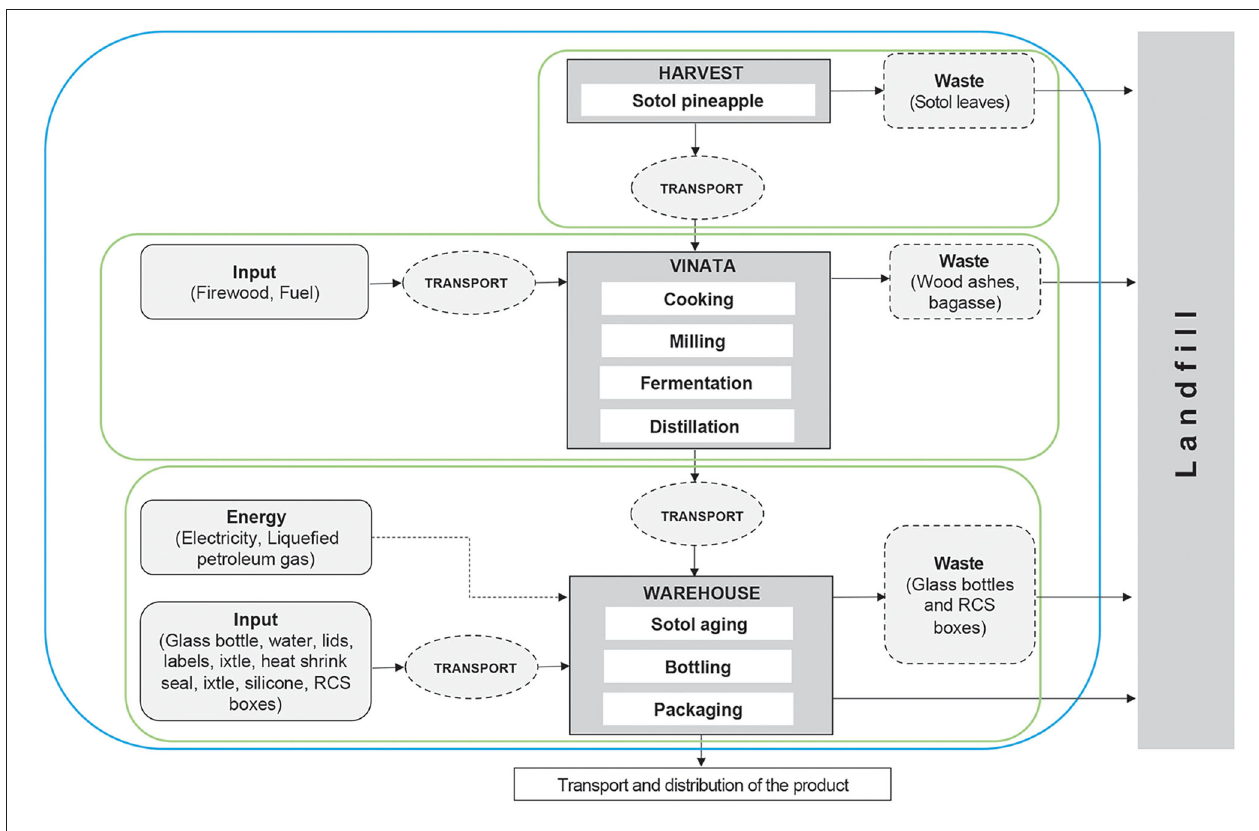
FIGURE 2 | System limits of artisanal sotol production.